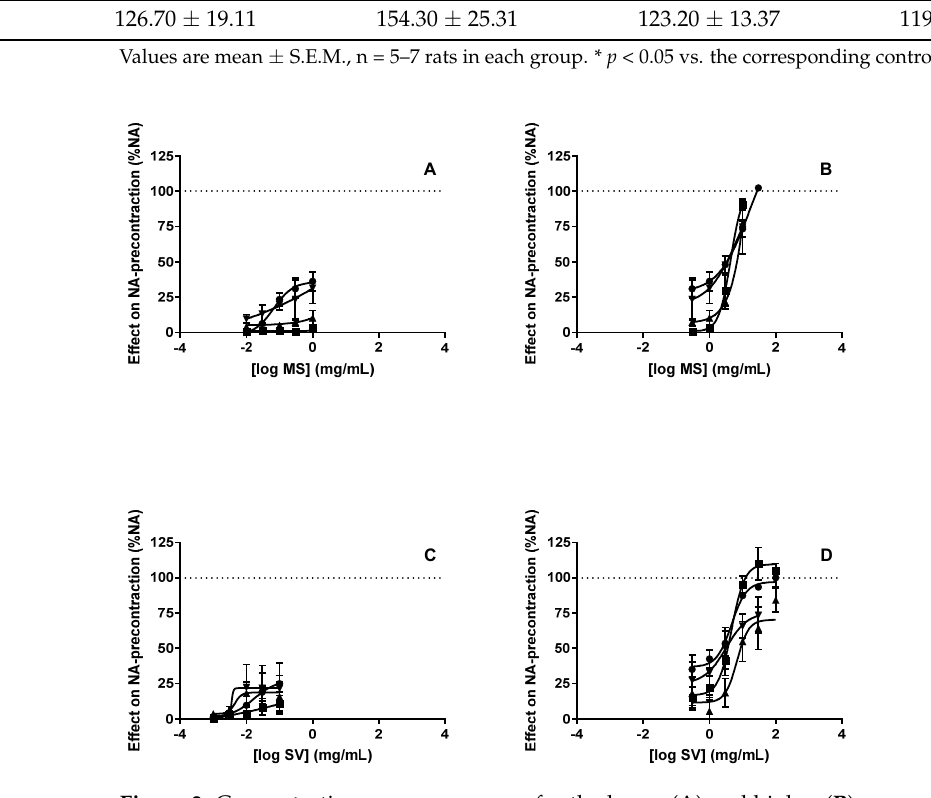
Figure 3. Concentration-response curves for the lower ( A ) and higher ( B ) concentrations of the M. suaveolens (MS) extracts and for the lower ( C ) and higher ( D ) concentrations of the S. verbenaca (SV), in the absence (control condition, circles) and in the presence of L-NAME 100 µ M (squares), Atropine 6 µ M (triangle) or Indomethacin 10 µ M (inverted triangle), on the rat thoracic aorta. Results expressed as % of the contraction induced by noradrenaline 5 µ M. n = 5–7 rats in each group. The vasorelaxant effect induced by lower concentrations of the SV extract tested was decreased by atropine 6 µ M and indomethacin 10 µ M but not by L-NAME 100 µ M, although none of these drugs altered the effect of the higher concentrations tested (Figure 3C,D and Table 3).